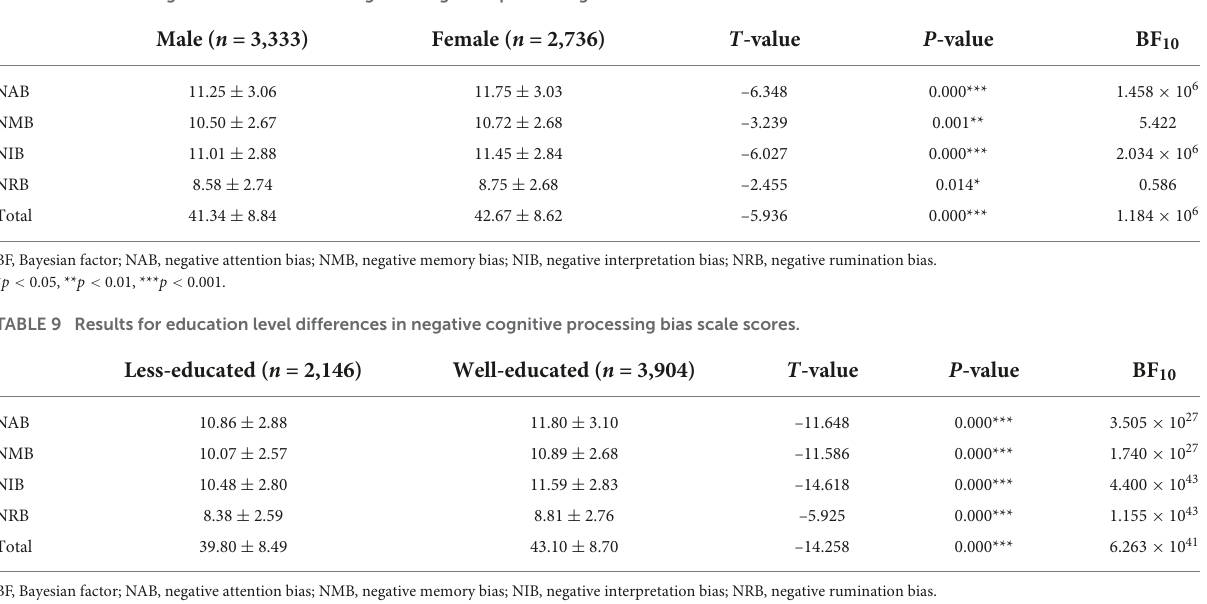
TABLE 8 Results for gender differences in negative cognitive processing bias scale scores.